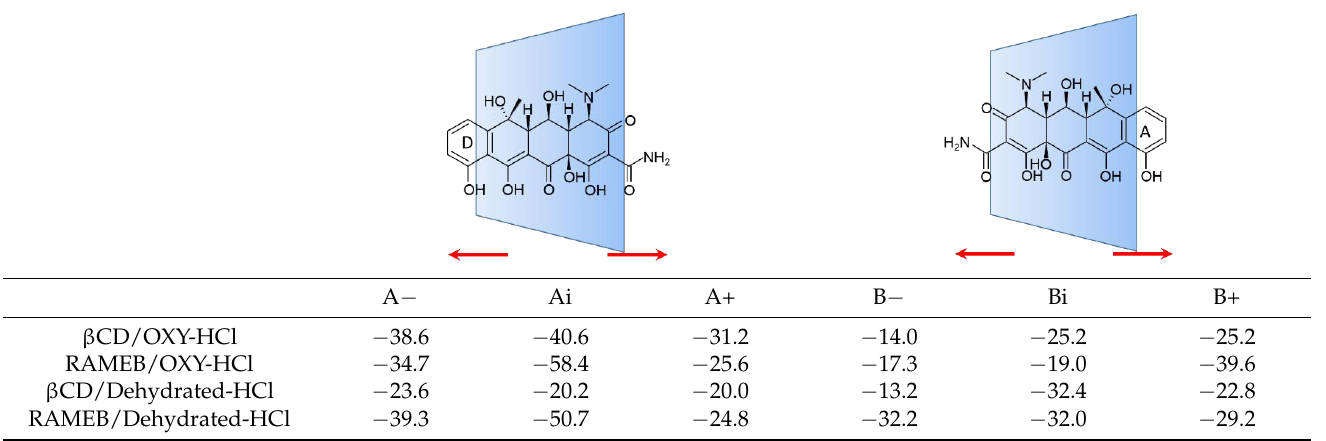
Table 3. The heat of formation differences (Kcal/mol) of the complete and incomplete inclusion compounds between CDs and oxytetracycline, relative to the free components.